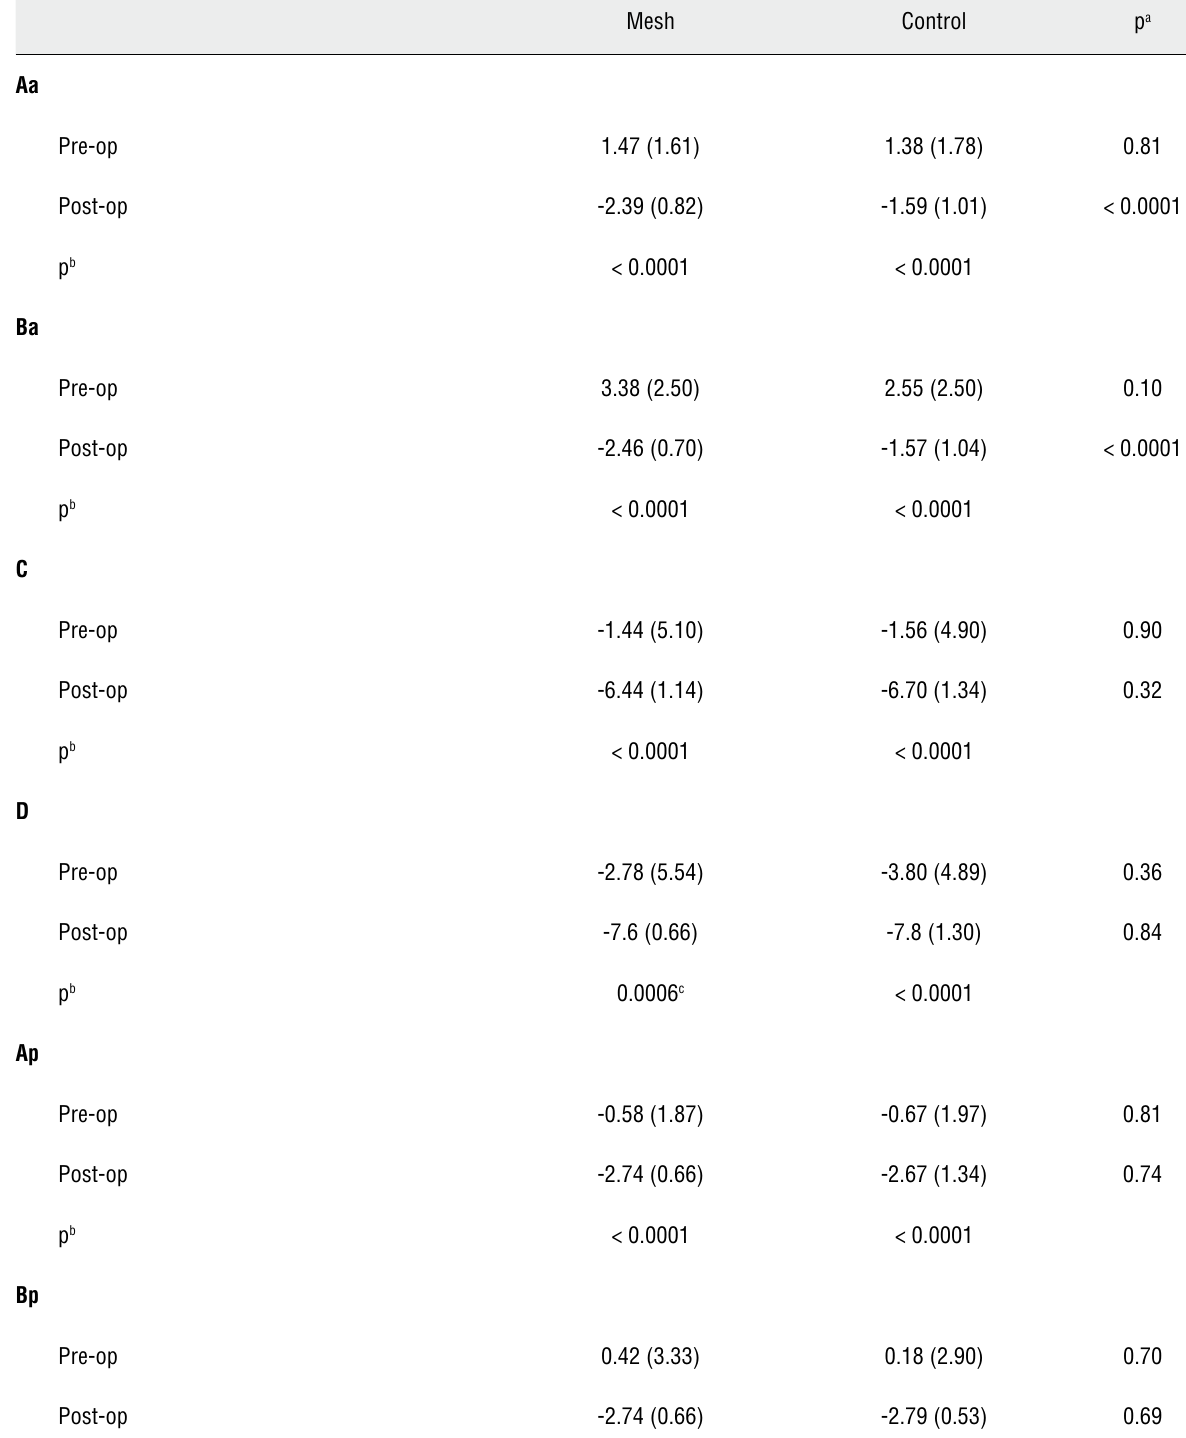
Table 2 - POP-q measurements in centimeters ± standard deviation (SD) at pre- and postoperatory periods from Mesh and Control groups